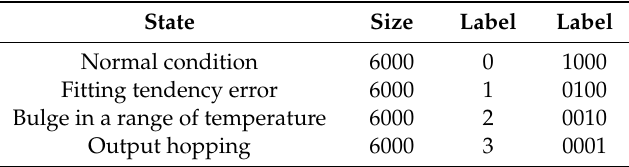
Figure 8. The descriptions of UAV-MGNC and variable temperature rig. ( a ) Description of UAV-MGNC, gyroscopes and accelerometers are the build-in components of UAV-MGNC; ( b ) Description of variable temperature rig, UAV-MGNCs are set inside of variable temperature rig. Table 2. MEMS inertial sensors fault data set.